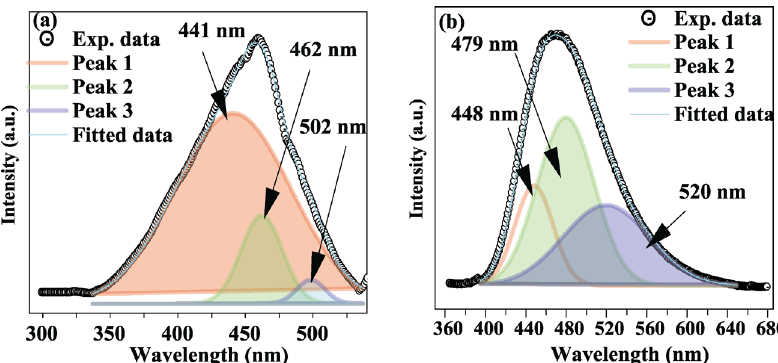
Fig. 11 Emission spectra of sintered samples of (a) SrCeO 3 and (b) Sr 2 CeO 4